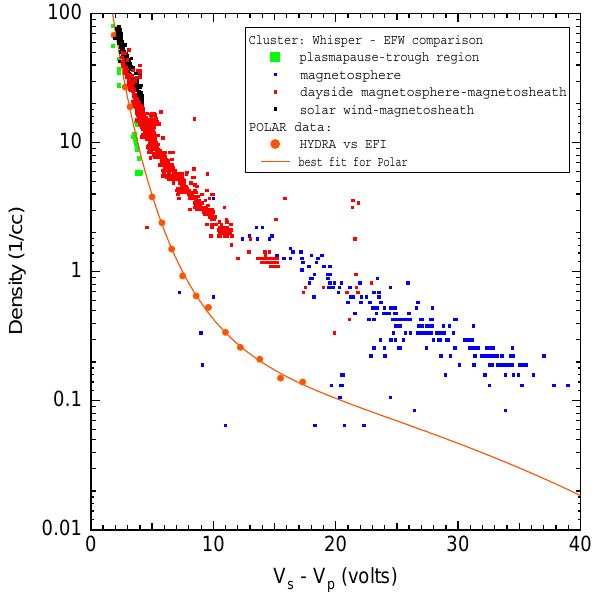
Fig. 3. Electron densities measured by Whisper given as a func- tion of the spacecraft-to-probe potential difference, V s − V p . V p is of the order of 1.0volt in a tenuous magnetospheric plasma ( N e < 1cm − 3 ), and is less than 1.0V relative to the plasma for higher electron